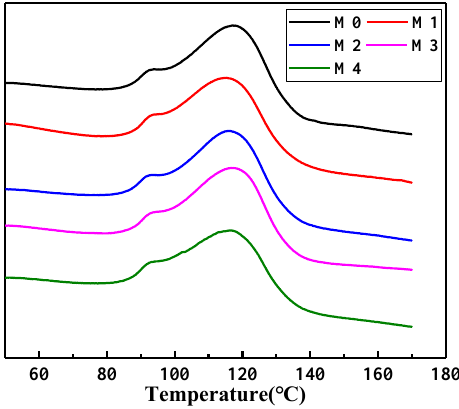
Figure 4. DSC diagram of the melting curves of the PVDF-HFP membranes prepared with mixed diluents. Table 2. The enthalpy of fusion and crystallinity of the PVDF-HFP membranes prepared with mixed diluent.